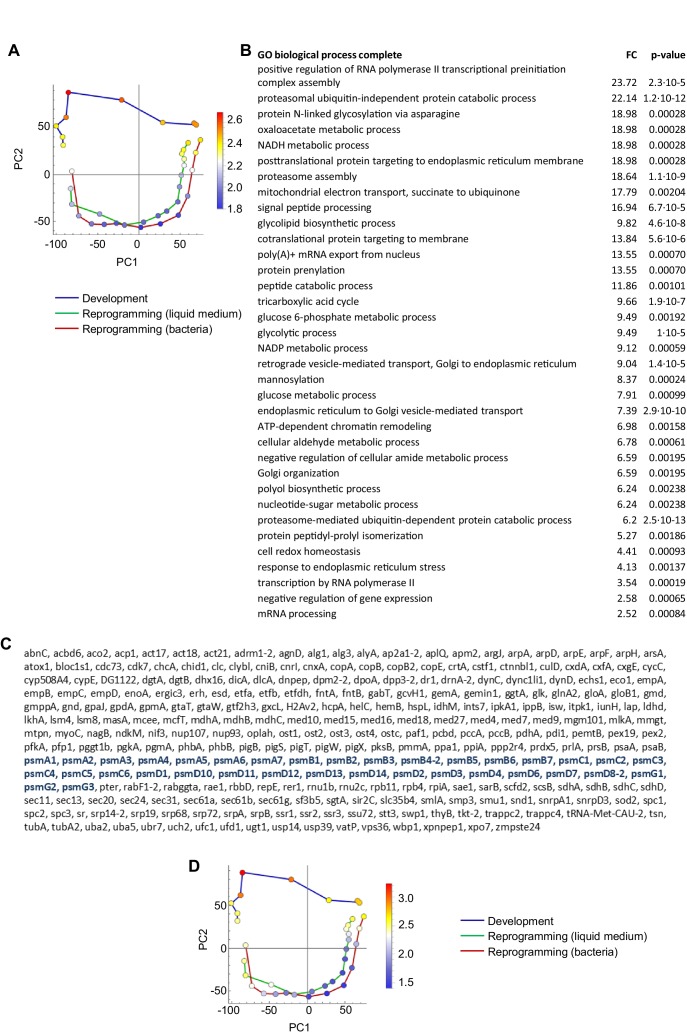
Genes specific to development, not dedifferentiation.(A) Overlay of genes used for GO analysis onto the PCA plot of population RNAseq data from Figure 2A. The genes selected were the top positively contributing genes to PC2 variance (547 genes). Colour indications on PCA plot based on mean of log10 counts. (B) Significantly enriched GO terms (p<0.05). Enriched terms relate to secretion, transcription and proteasome. (C) Enrichment of proteasomal genes (blue) in the strong positive PC2 loadings. Only genes with annotated names are shown in this list. (D) Same PCA plots as in A, overlaid with expression of proteasomal genes.